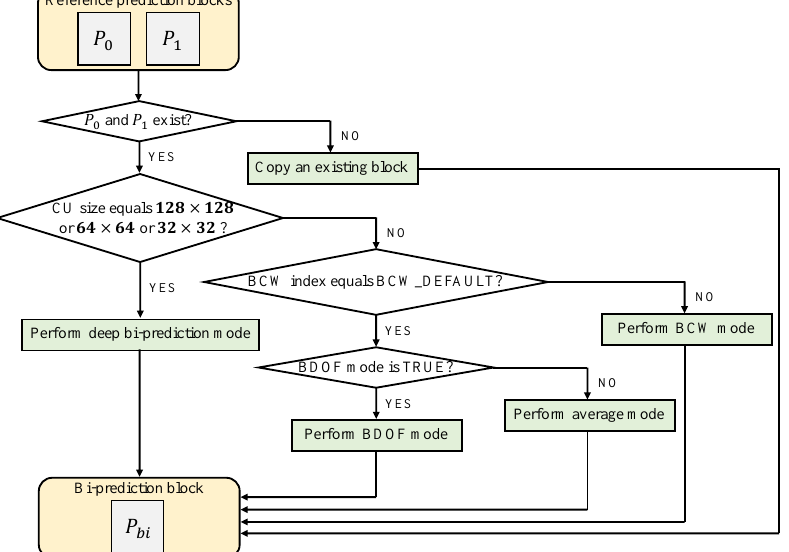
Figure 4. The flowchart of the bi-prediction in the motion compensation process with the proposed method in